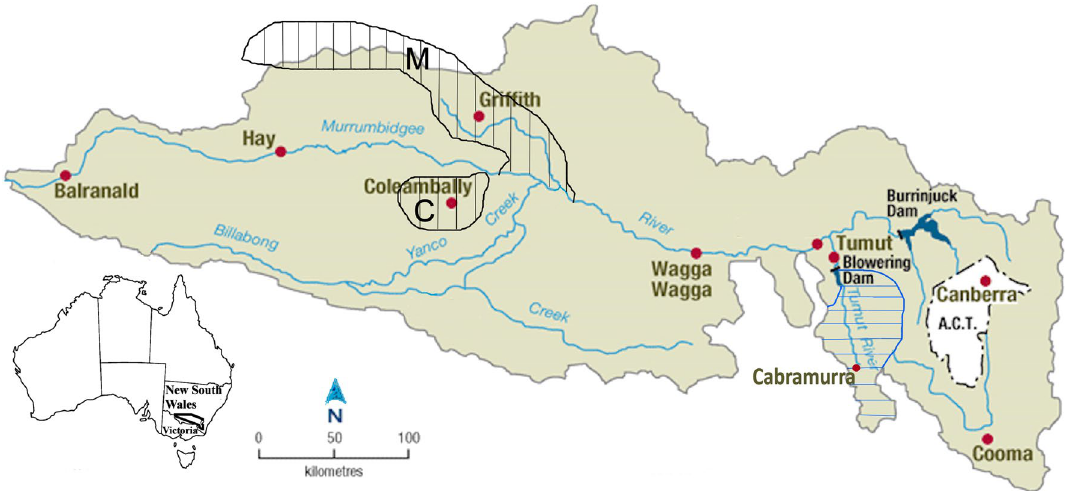
Figure 1. The Murrumbidgee River and catchment area. M Murrumbidgee irrigation area (hatched black), C Colleambally irrigation area (hatched black). Snowy mountains hydroelectric scheme (hatched blue). The